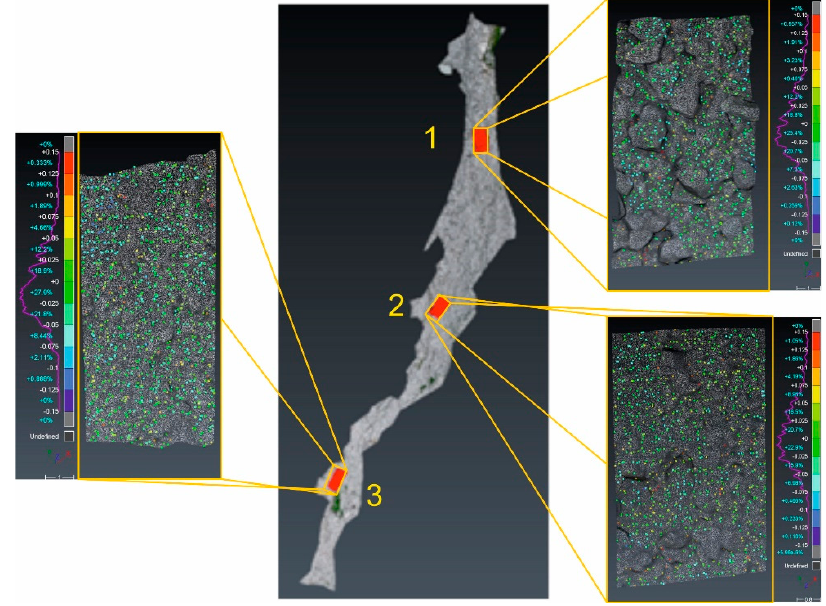
Figure 19. Height comparison of UAS and ALS point clouds on areas.